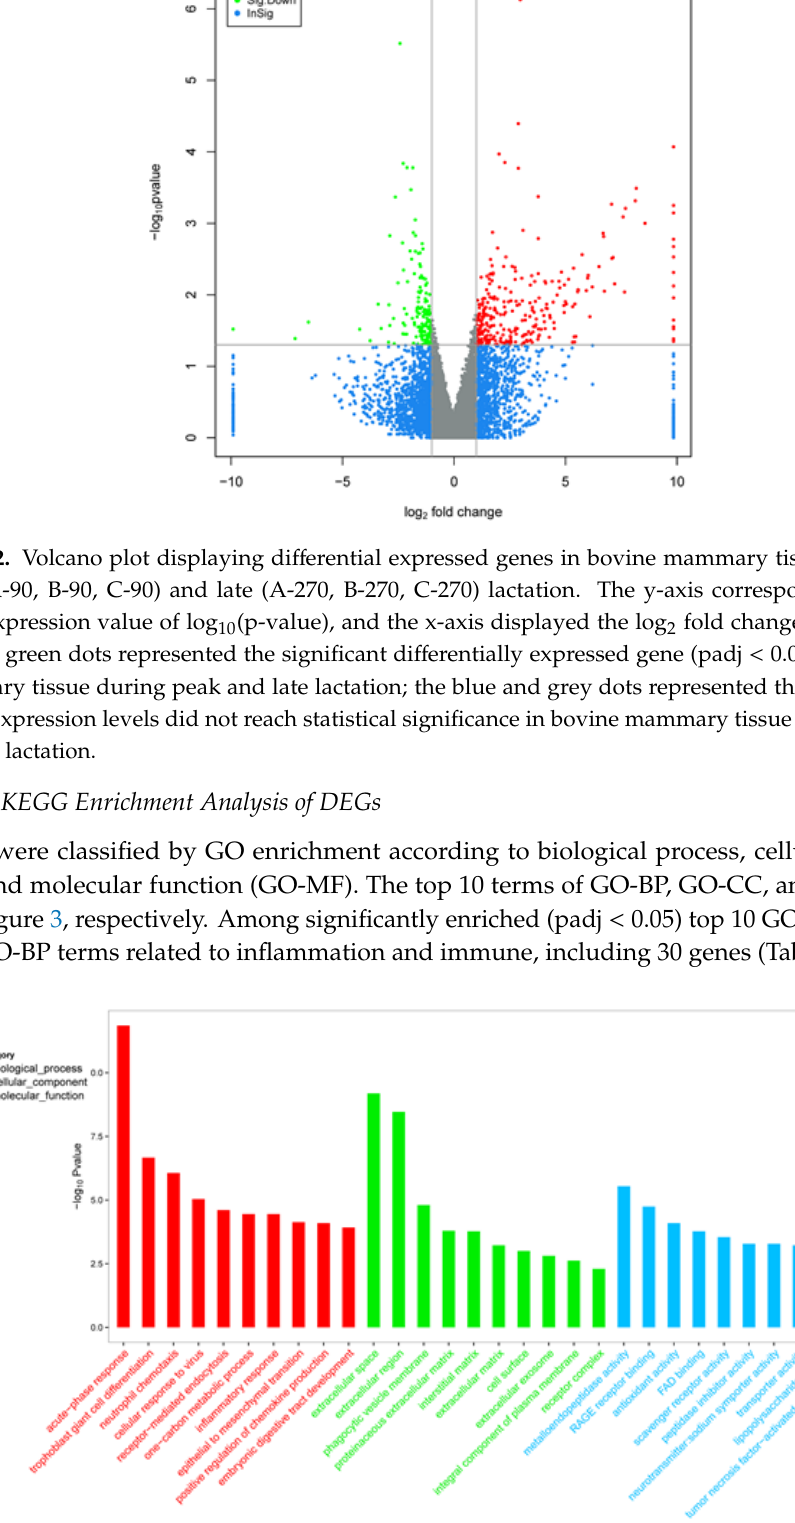
Figure 3. Gene ontology functional enrichment analysis of di ff erentially expressed genes. Only top 10 significantbiologicalprocess, cellularcomponent, Figure3. Gene ontology functional enrichment analysis of differentially expressed genes. Only top 10 significant biological process, cellular component, and molecular function terms were listed, respectively.